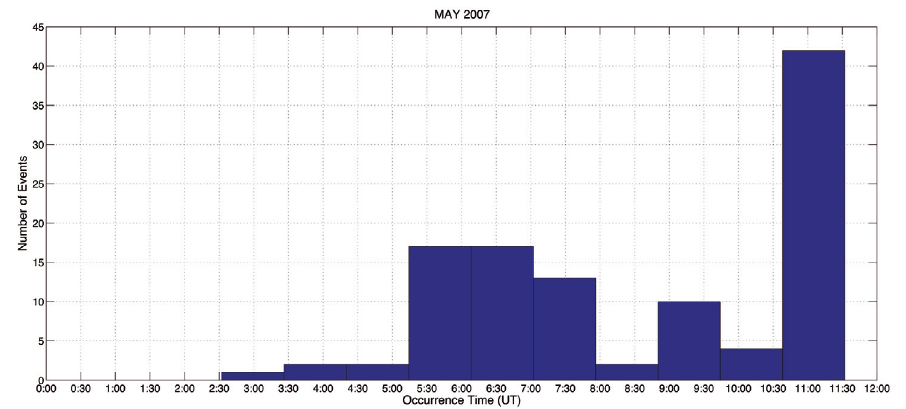
Figure 4 (continues from previous page). VLF event occurrence time histograms for January to May 2007, as indicated. June is not included because of the low event occurrence.